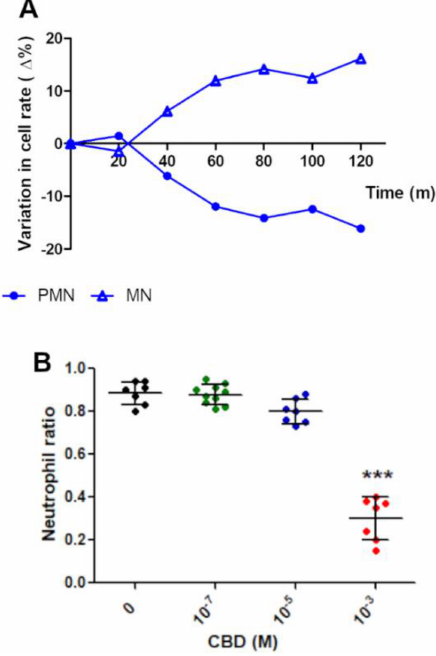
Figure 3. CBD accelerates the decrease in PMN/MN rate. ( A ) Spontaneous nuclear transformation from PMN to MN forms affects no more than 20% of normal PMN population in a symmetric mode. ( B ) A significant drop in the PMN/MN ratio is observed when PMNs are exposed to higher CBD concentrations. Results are expressed as mean ± SD ( p < 0.0001). *** indicate the significance differences relative to 0 M of CBD.